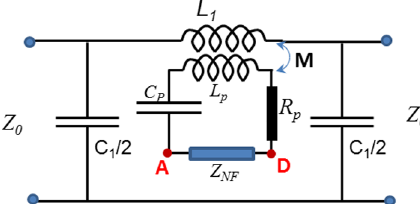
Fig. 1. Equivalent circuit modeling a SRR array: PI network of a transmission line connected, via a mutual inductance, to a RLC series resonant circuit. ( L p : loop inductor, C p : loop+ lumped capacitor, Z NF : NF impedance, R p : loop resistance).